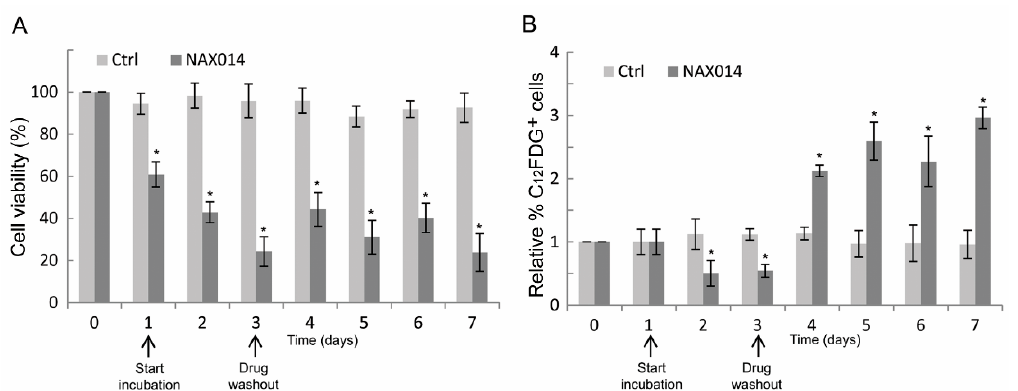
Figure 4. Effect of transient exposure to NAX014 on SK-BR-3 cell viability and cell senescence. SK-BR-3 cells were seeded (day 0) and exposed to 16.9 μ M NAX014 (start incubation), or control vehicle (DMSO), for 3 days, after which viable cells were recultured in drug-free medium (drug washout) for additional 4 days, and then analyzed at each time-point for cell viability and cell senescence. ( A ) Cells were counted after trypan blue staining and cell viability was expressed as percentage (%) = (total viable cells (unstained)/total cells (stained and unstained)) × 100. * p ≤ 0.05 versus control cells treated with DMSO ( B ). At each time-point, the quantification of cell senescence was assessed by C 12 FDG staining and FACS analysis. Data are presented as the means ± SD of the relative percentage of C 12 FDG-positive cells. * p ≤ 0.05 versus control cells treated with DMSO.